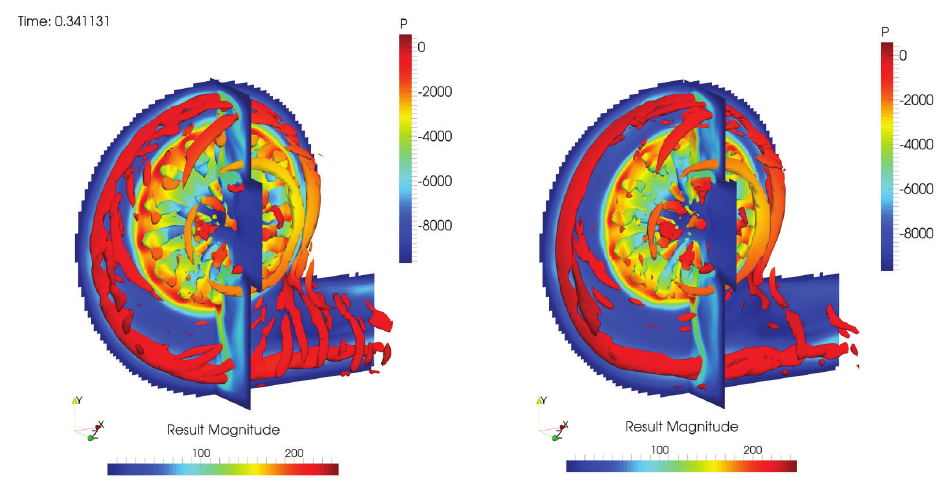
Figure 25 - Instantaneous field of velocity magnitude and isosurfaces of the criteria Q = 10 6 at t = 0:34s. Left: original rotor; right: modified